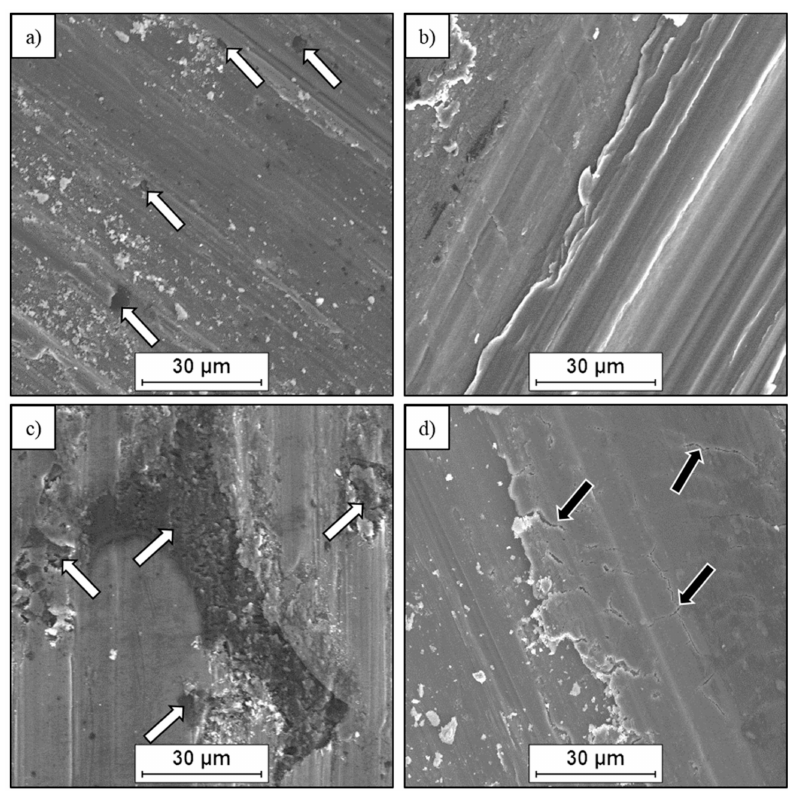
Figure 13. SEM micrographs of materials surface after dry friction tests: ( a ) C of –Mg composite, ( b ) Mg, ( c ) C of –AZ31 composite, ( d ) AZ31 alloy, microareas of carbon component (white arrows), cracks and delamination e ff ect (black